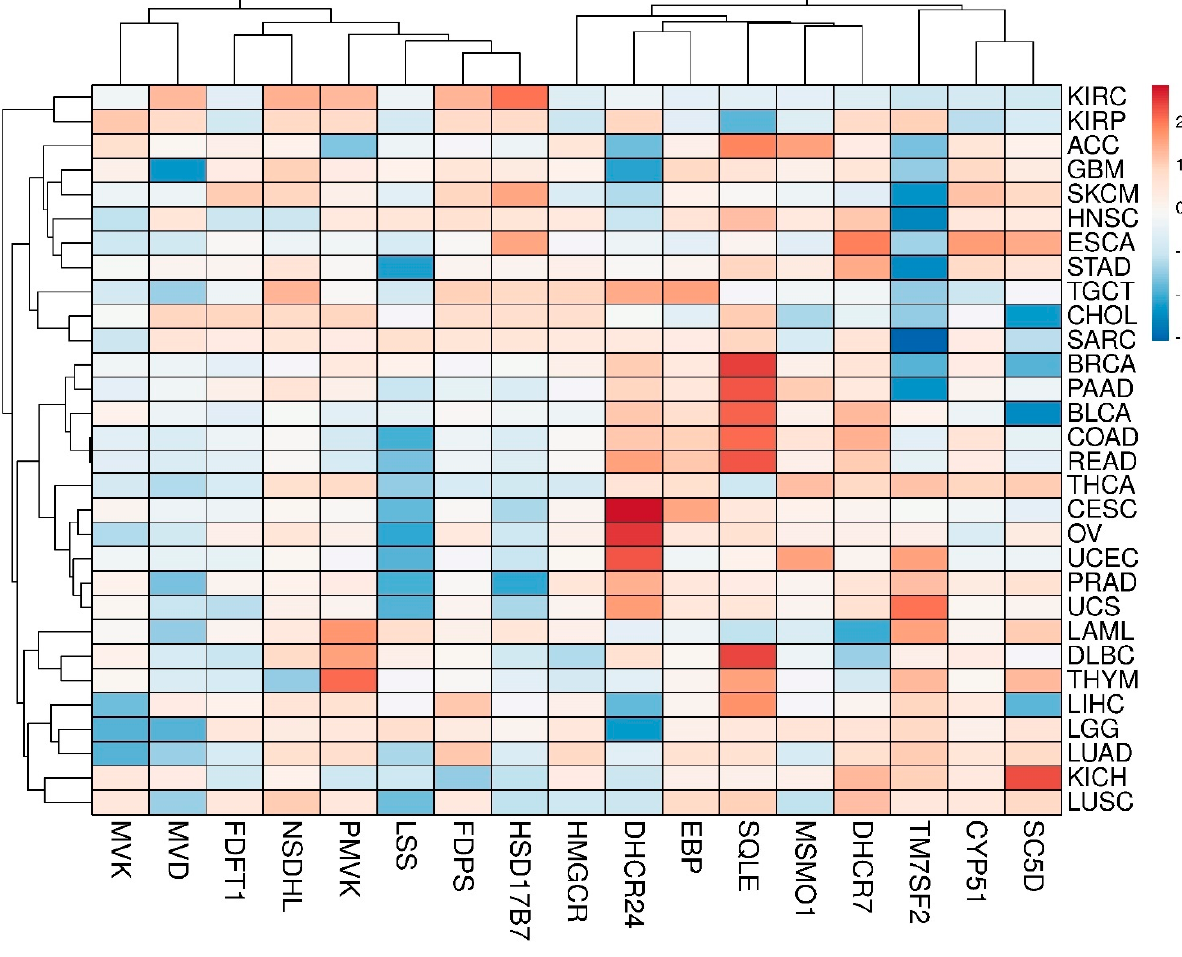
Figure 2. The clusterogram of expression profiles of genes, involved in cholesterol synthesis pathway, in different tumors. The color scale shows the cluster distances.